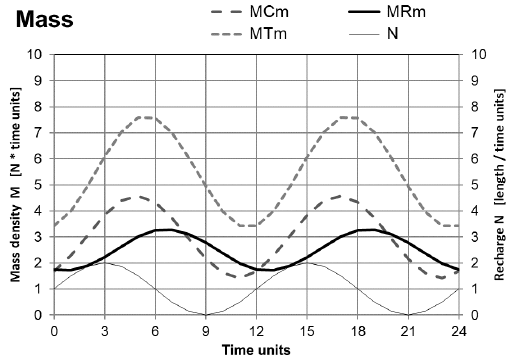
Figure 2. Time series of recharge N , catchment mass M C , river network mass M R and total masses M T for the synthetic case at